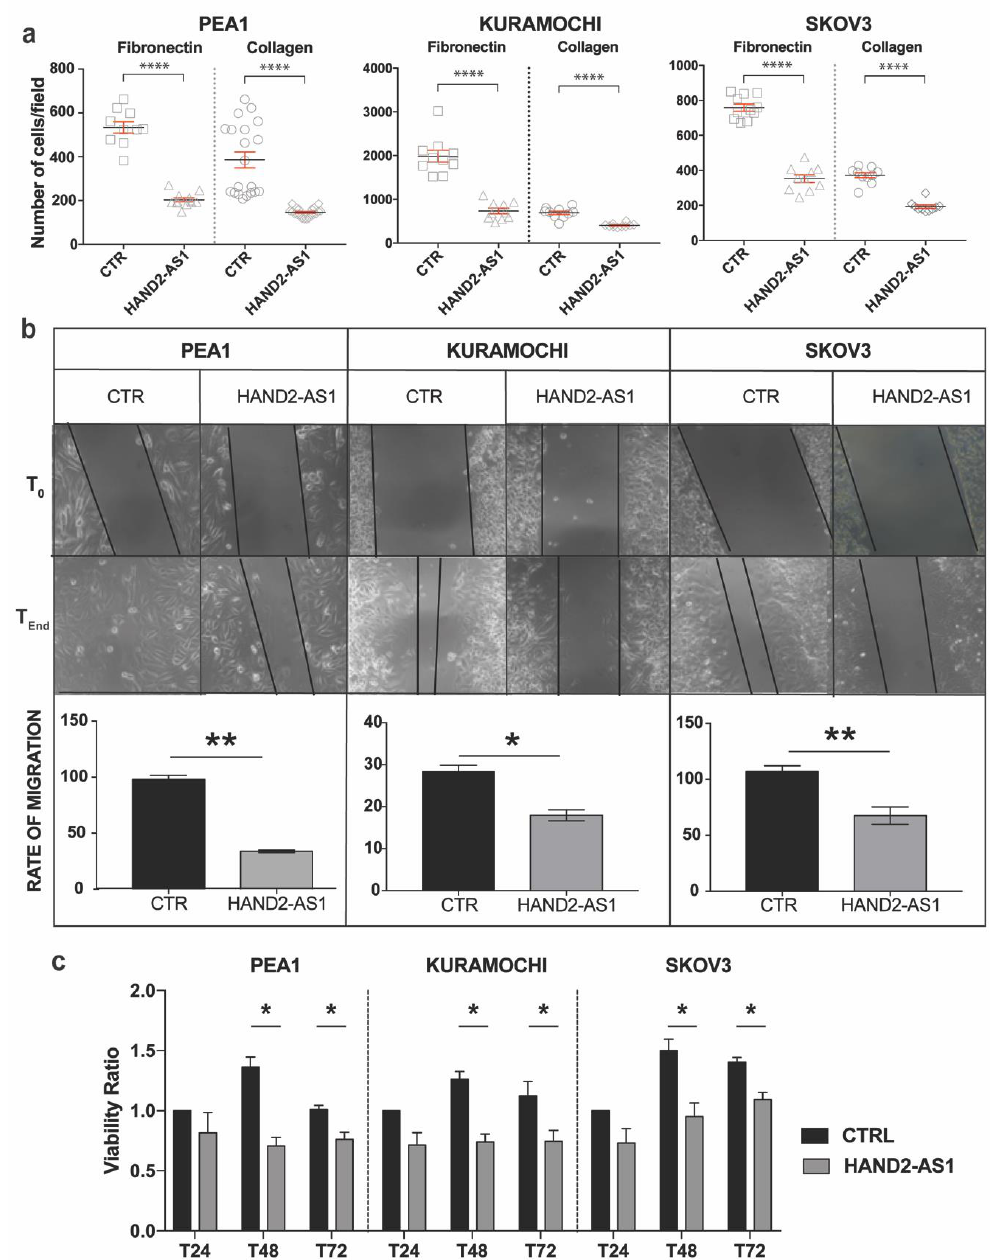
Figure 3. E ff ect of HAND2-AS1 expression on physiological properties in three cell lines–after PEA1, KURAMOCHI, and SKOV3 cells after transfection with HAND2-AS1 and control expression vectors: ( a ) adhesion to fibronectin and collagen I-coated ECM substrates quantified in terms of the number of attached cells per field, ( b ) migration denoted by representative images and quantitative representation showing cumulative rates of migration, and ( c ) the viability ratio between the absorbance of control and HAND2-AS1 vector obtained at 24, 48, and 72 h represented as T24, T48, and T72. Values from experiments (n = 3) are expressed as means ± SD normalized using control vector-treated samples. For the adhesion assay, the Mann–Whitney U test was used to assess significance with a p -value cutoff at p ≤ 0.05 with asterisks denoting significance as **** p ≤ 0.0001. Significance in the migration assay and viability assay was assessed by calculating the p -value between control and HAND2-AS1-transfected samples using Paired and Student’s t-test (two-tailed), respectively, with the cuto ff as p ≤ 0.05 wherein asterisks denote significance. ns not significant, * p < 0.05, ** p <